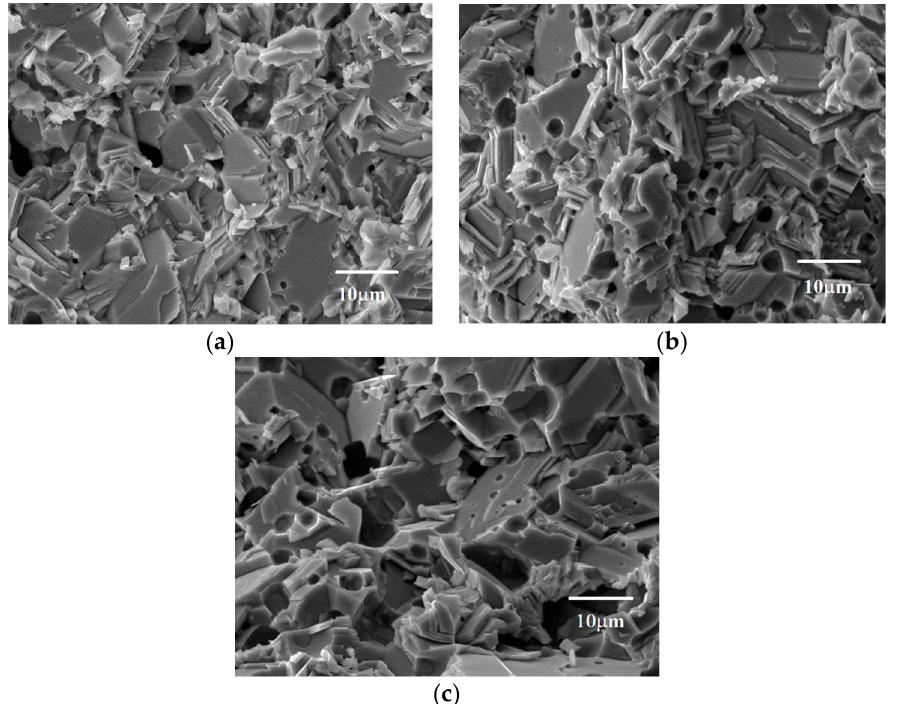
Figure 3. Scanning electron microscopy (SEM) graphs for the Cu 2 Se samples sintered under different conditions: ( a ) 973 K for 20 h; ( b ) 1173 K for 2 h; ( c ) 1173 K for 20 h.